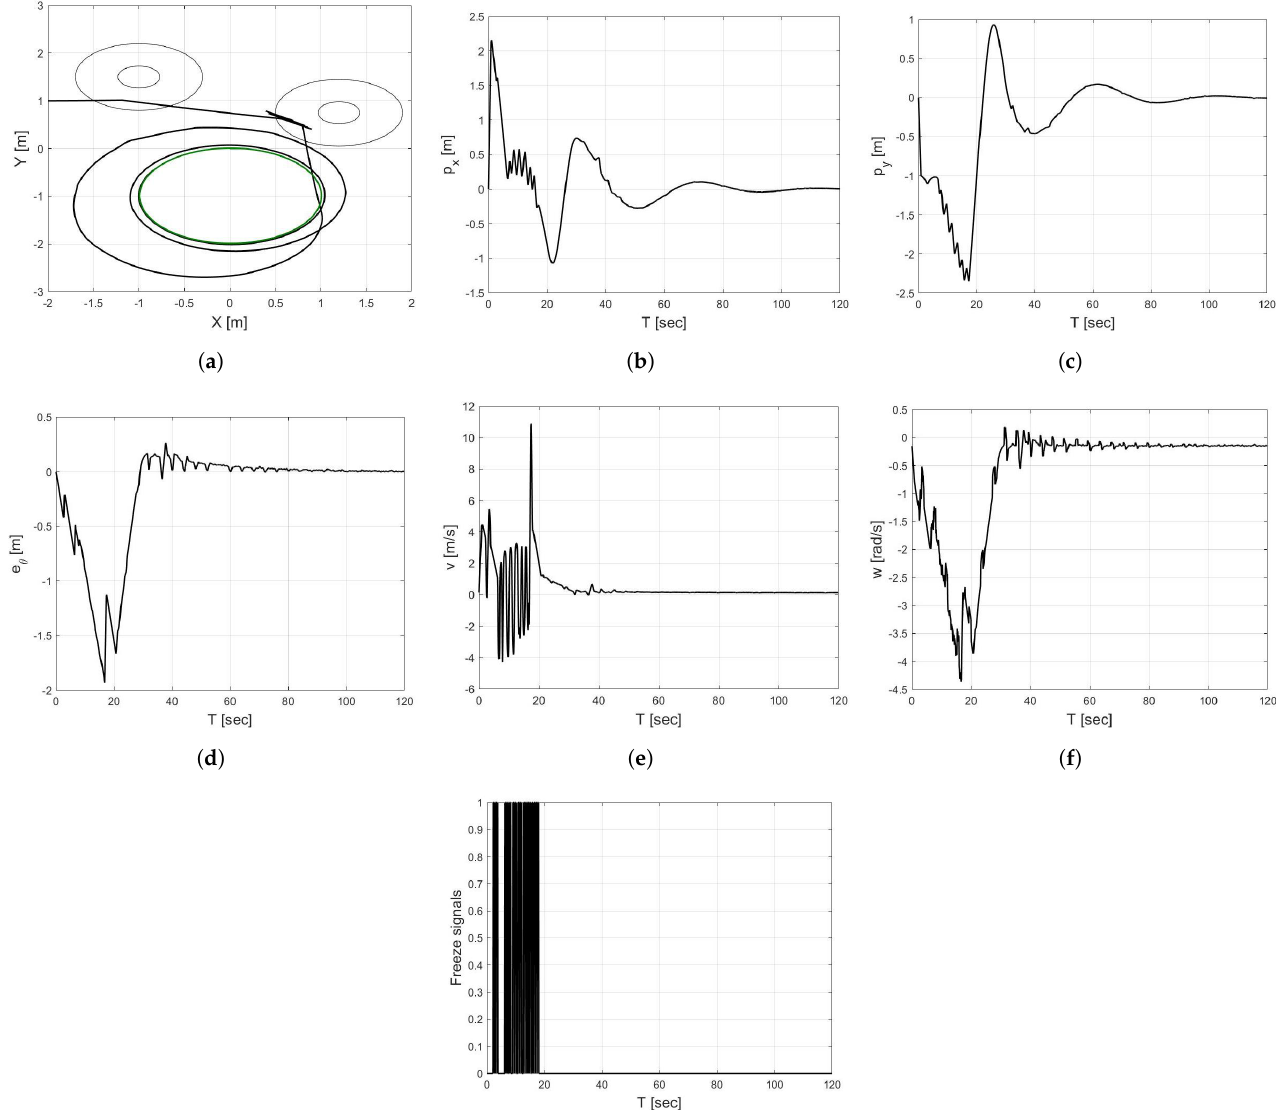
circular shape. Figure 6a shows the paths of both the robots in the XY plot. The green color indicates the path of the virtual robot, which starts from (0, 0) coordinates and moves in a circle in the anti-clockwise direction. The robot starts from (0, 1), avoids the two obstacles in its way, and converges to the desired trajectory at the end. Figure 6b shows the error in the x -coordinates as a function of time. As time passes, the controller helps the robot to achieve near-zero error in the x -axis. Figure 6c shows the error in the y -coordinates as a function of time, which also shows that error in the y -axis converges near zero, due to the controller. The robot orientation error also tries to converge to zero, as shown in Figure 6d. The real-time control signal generated by the controller (linear velocity and angular velocity) for the robot can be shown in Figure 6e,f. However, in these plots, some high linear velocities and angular velocities are generated. In that case, the real robot only moves to its top speeds. Freeze signals for the robot can be seen in Figure 6g, where zero means no freeze signal is generated and one unit shows that the robot is frozen. These are generated by the controller when the robot is in the potential field near the obstacle.